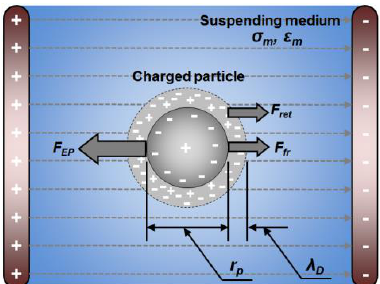
Figure 2. Electrophoretic motion of a charged particle in a direct current (DC) electric field. Reproduced from [40], with the permission of AIP Publishing (2012).